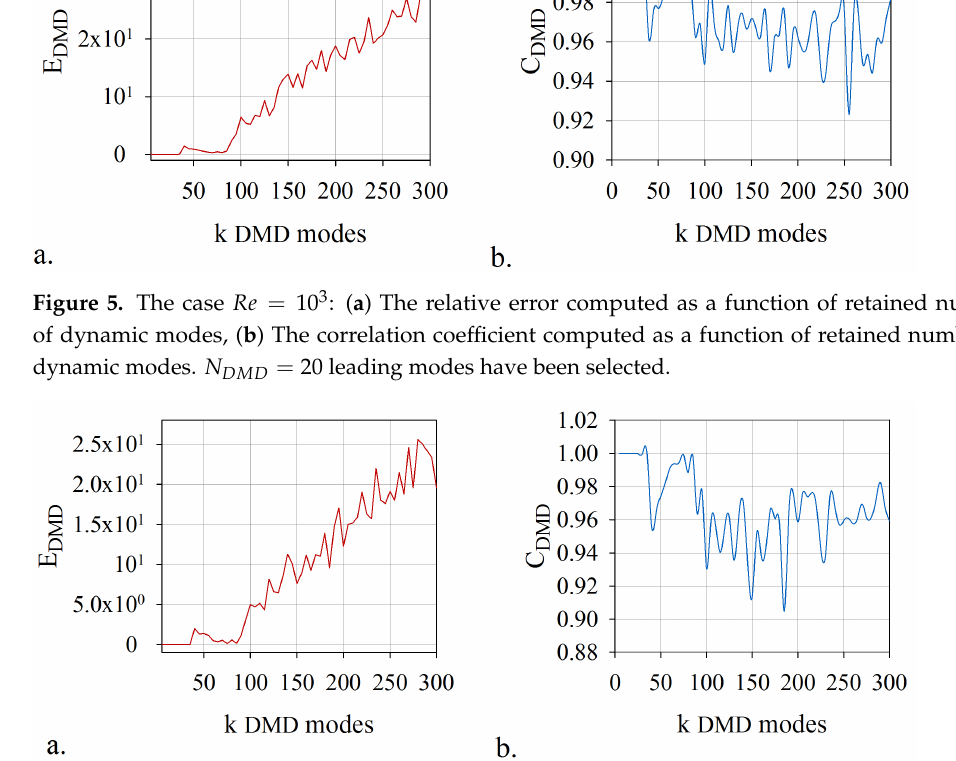
Figure 6. The case Re = 10 4 : ( a ) The relative error computed as a function of retained number of dynamic modes, ( b ) The correlation coefficient computed as a function of retained number of dynamic modes. N DMD = 20 leading modes have been